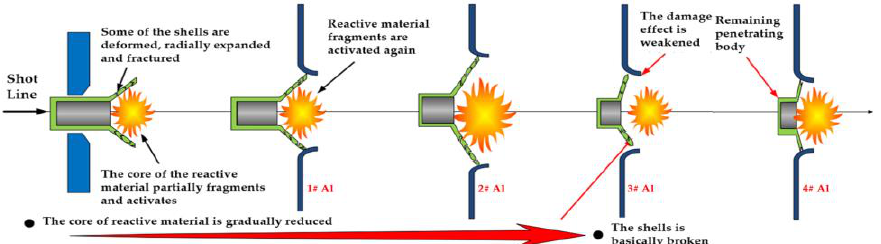
Figure 1. The process of action of RMP impacting a MLAT.